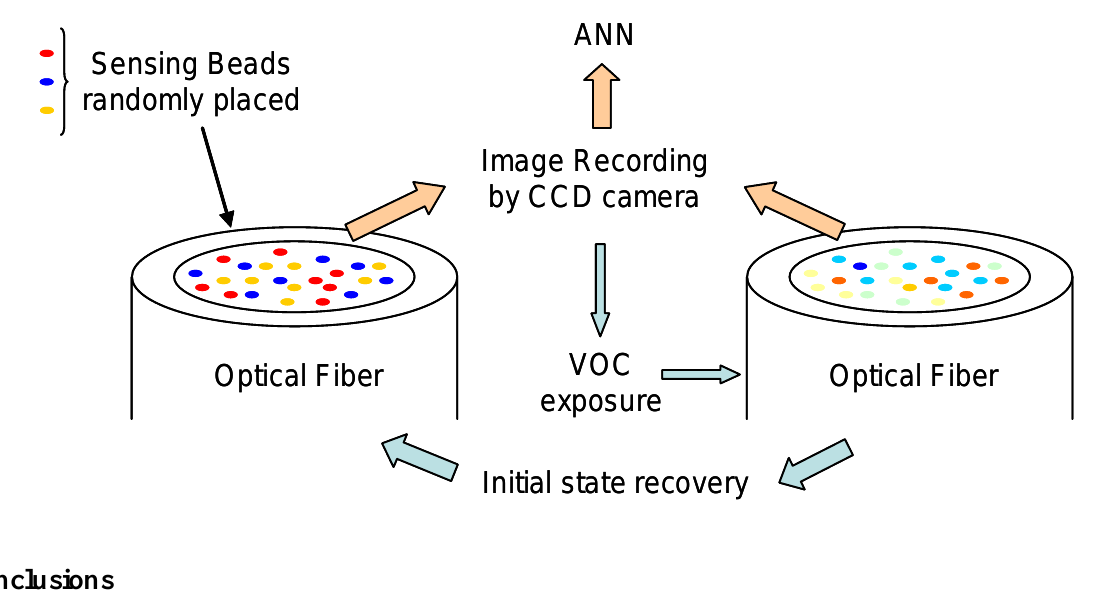
Figure 24 . Scheme of an image array